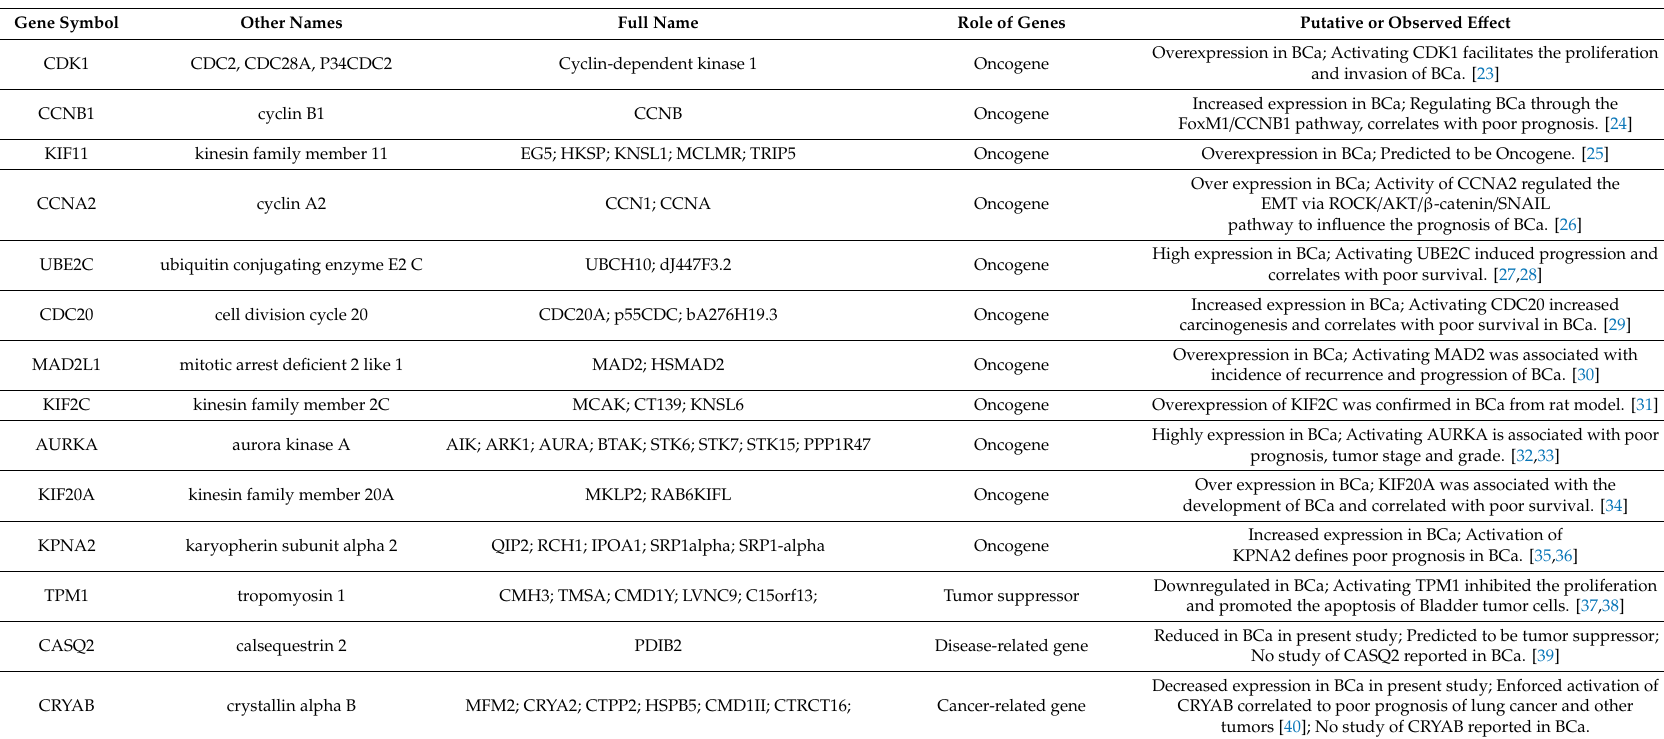
Table 2. Functional roles and general information of the 14 hub genes in